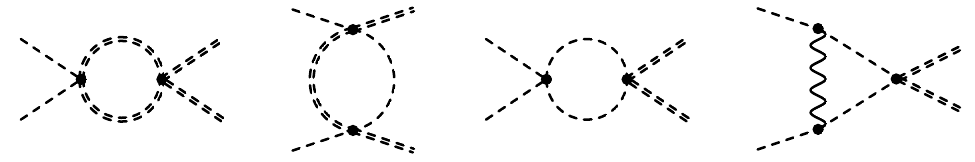
Figure 8 . Examples of one-loop contributions to the renormalisation of the coupling (cid:20) . The line styles and their meanings are analogue to those of (cid:12)gure 5.